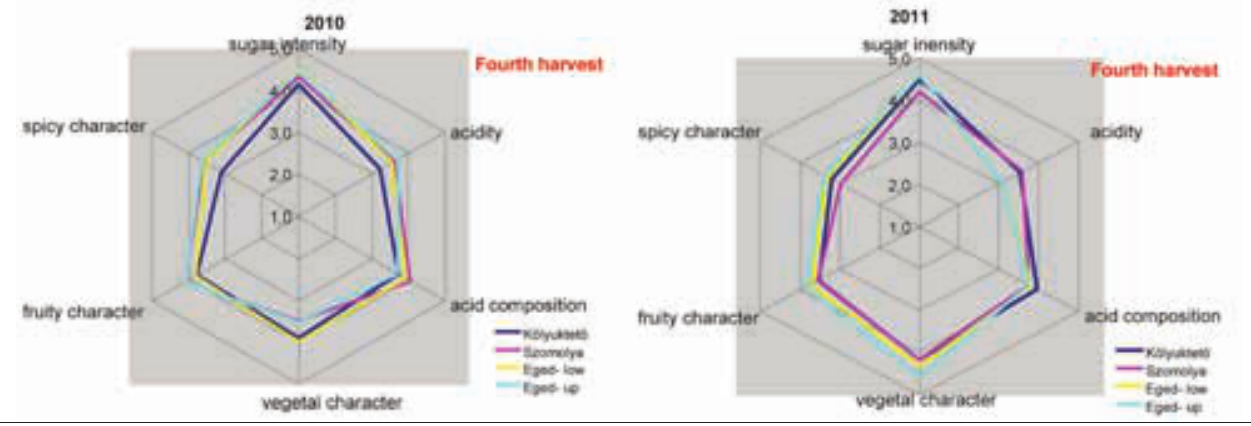
Figure 2d: Main sensorial characters of the pulp (2010-2011- Fourth harvest